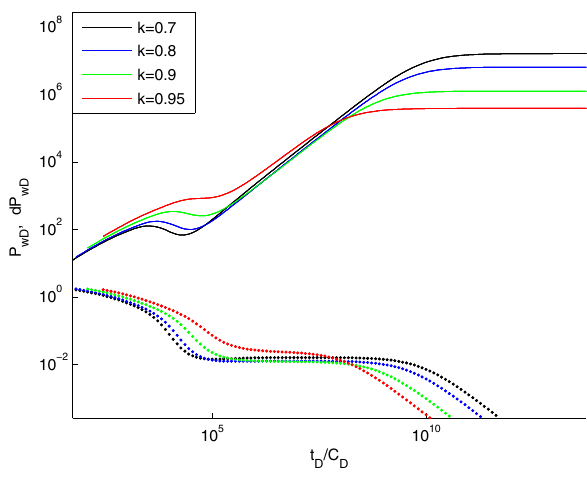
Fig. 5 Effect of R D on the characteristic curves Fig. 6 Effect of k on the characteristic